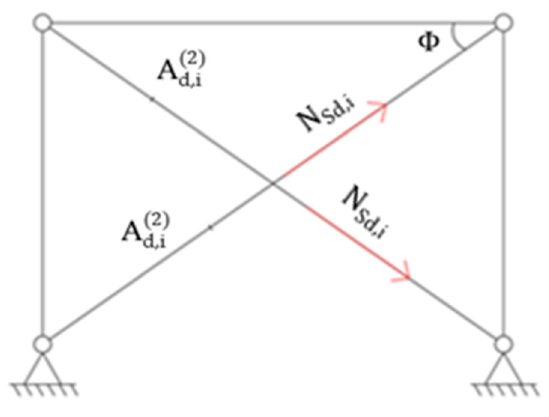
Figure 7. Calculation scheme of step 3.